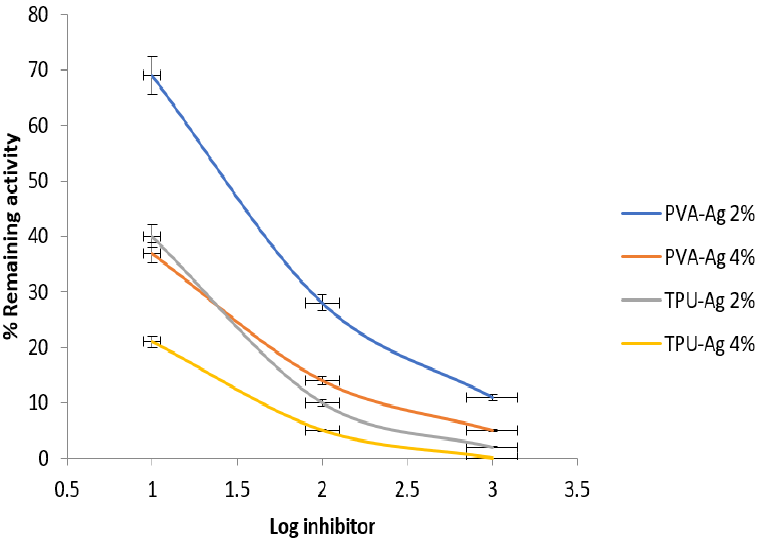
Figure 5. Percentage of remaining activity of blocking viral fusion of SARS-COV-2.